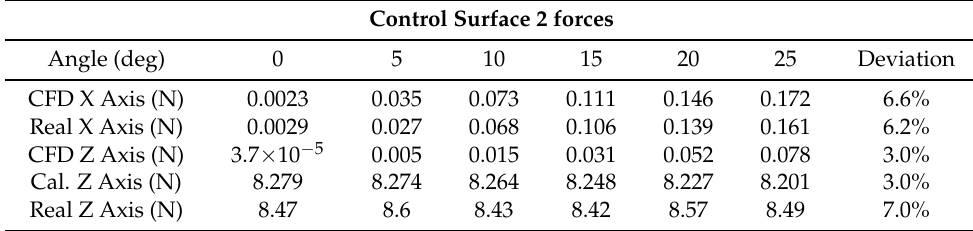
Table 4. Forces generated by Control Surface 2 at different deflection angles.